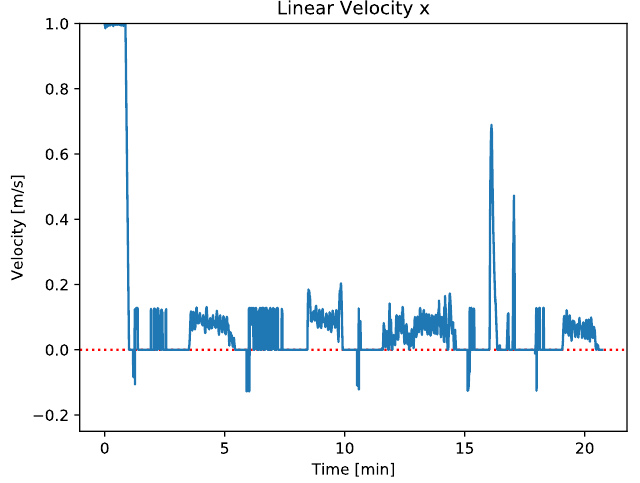
Figure 14. The blue line represents the ASV linear normalized speed ˙ x extracted from the tracking algorithm, being 1 the maximum and -1 the